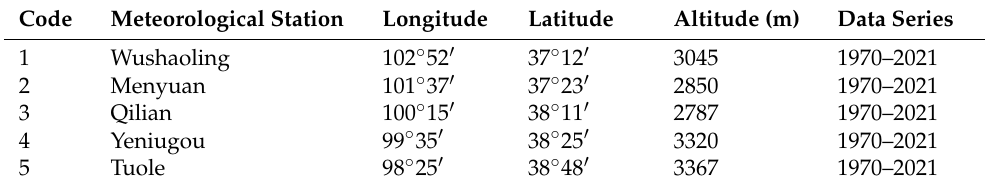
Table 2. Basic information on meteorological stations in the